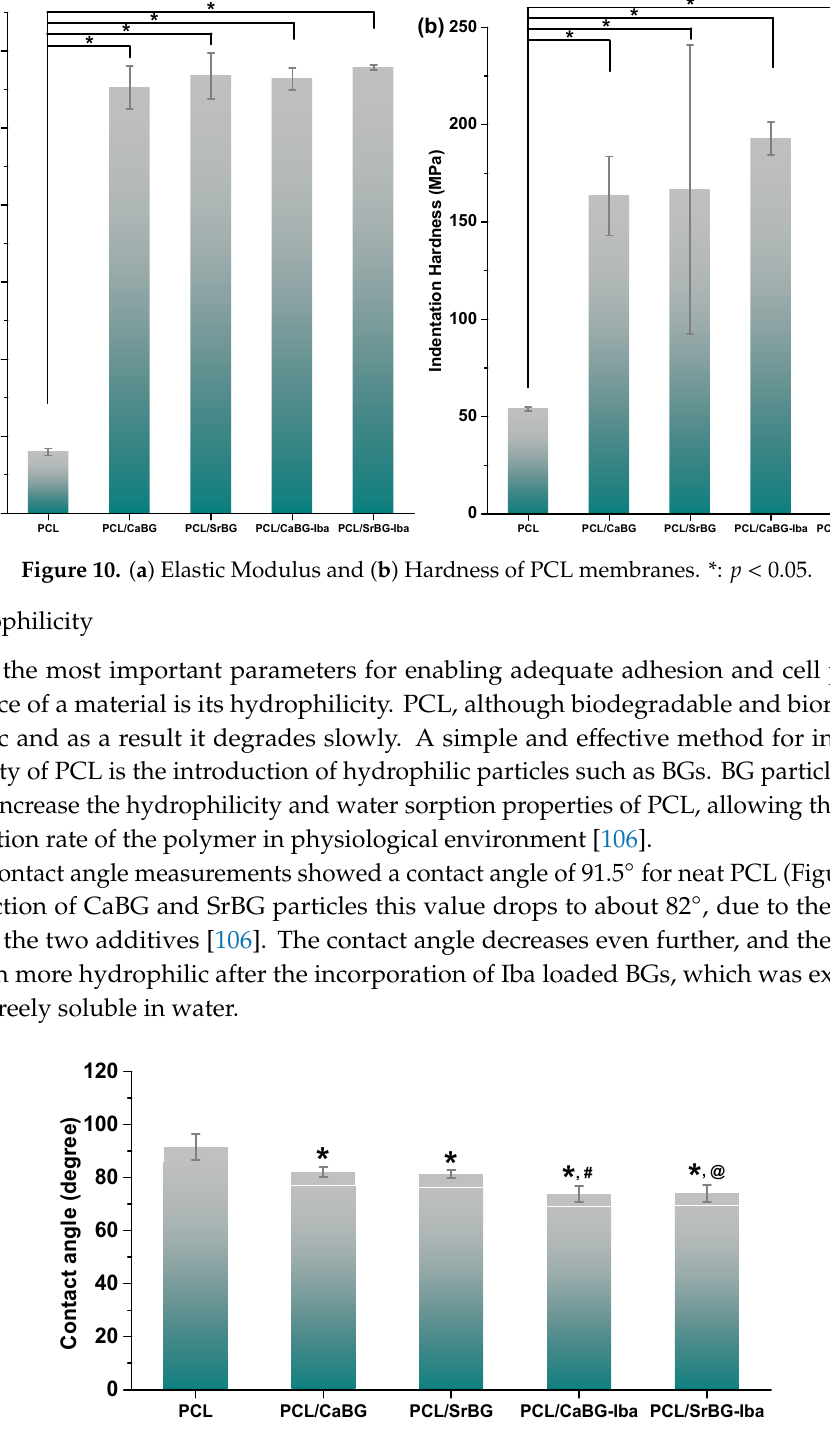
Figure 11. Water contact angle values of composite thin films. *: p < 0.05 compared to PCL, # compared to PCL/CaBG, @ compared to PCL/SrBG.